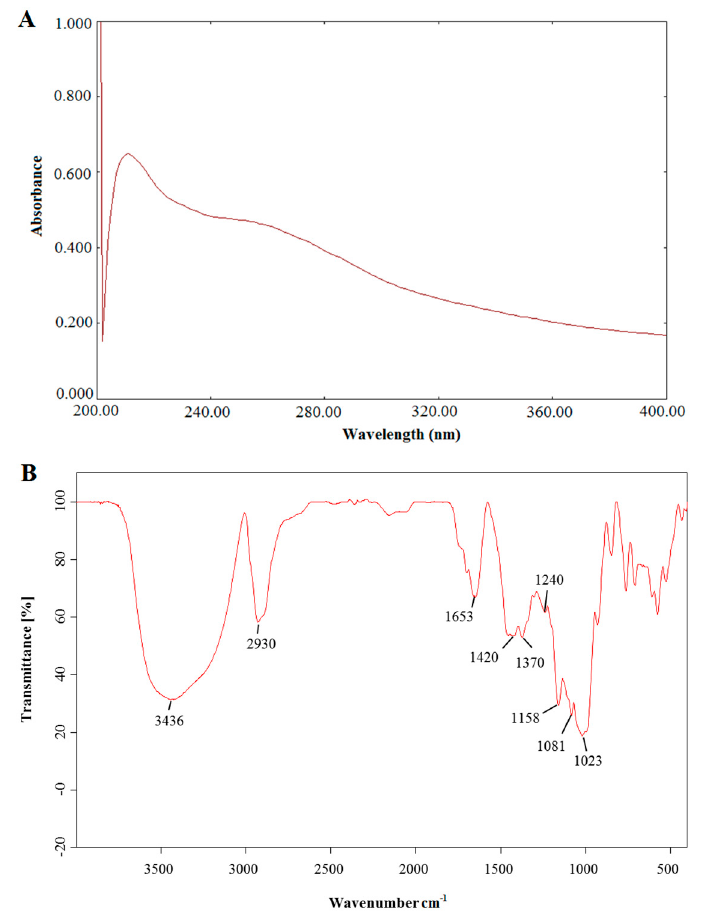
Figure 4. UV-vis spectra ( A ) and FT-IR spectra ( B ) of PSA.